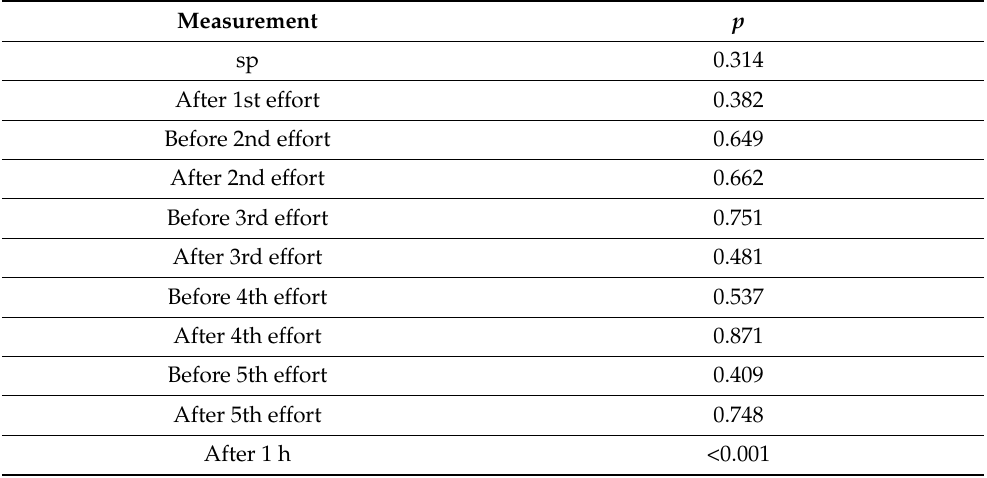
Table 6. Differences in lactate levels between 21 ◦ C and 31 ◦ C, separately for each measurement (ANOVA, planned